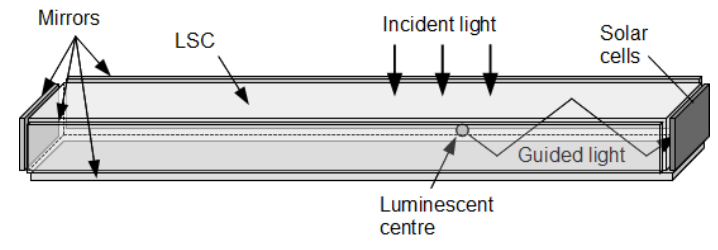
Figure 1. Luminescent solar